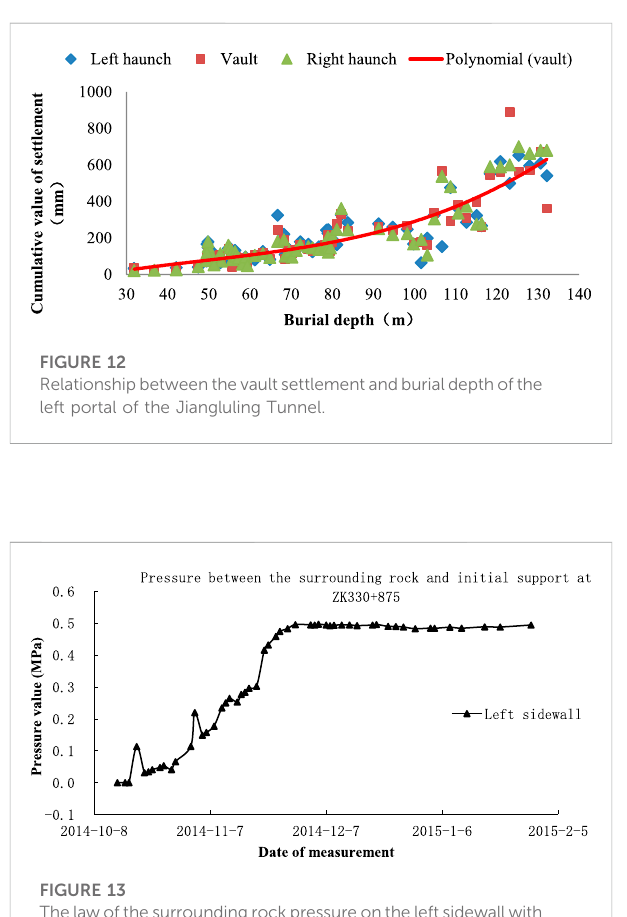
FIGURE 13 Thelawofthesurroundingrockpressureontheleftsidewallwith time at Cross-section